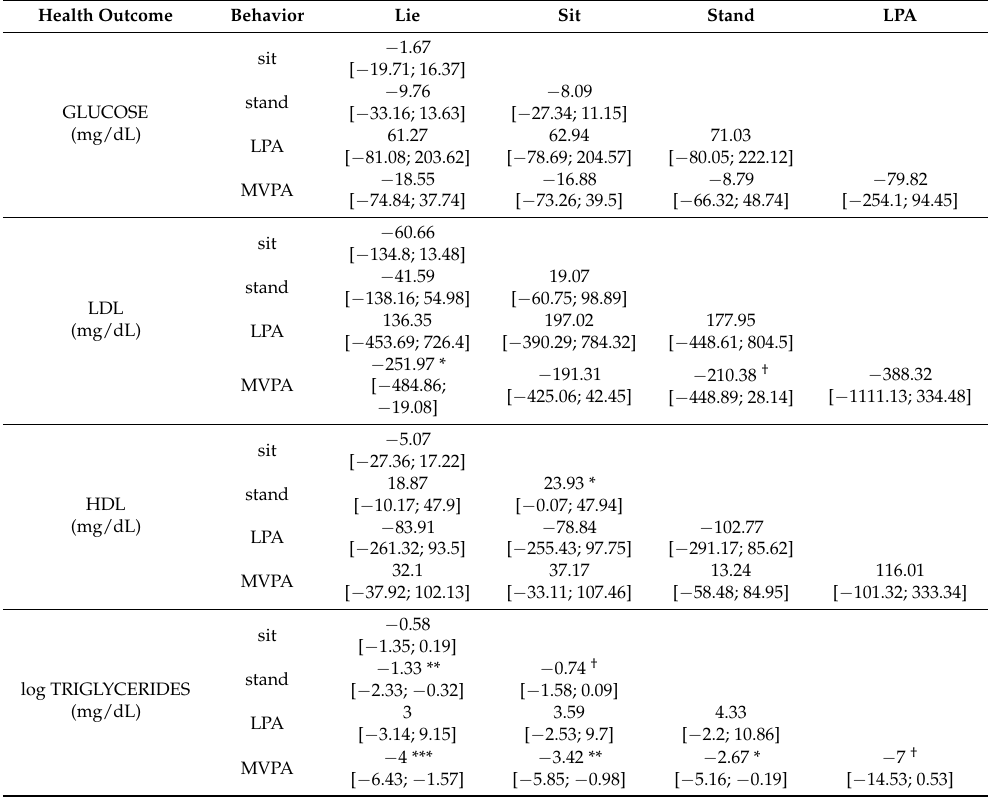
Table 3. Estimated coefficient of linear iso-temporal substitution models. The coefficients are the estimated change in y due to reallocation of a time unit from one state (column) to another (row). Here, a unit represents the whole time budget. Hence, a reallocation of 1% (0.01) of the total time from sitting to standing, is associated with a change in fasting high density lipoprotein concentration (HDL) of 23.93 × (0.01) ≈ 0.24 mg/dL. Levels of p -values: † <0.1; * <0.05; ** <0.01; ***